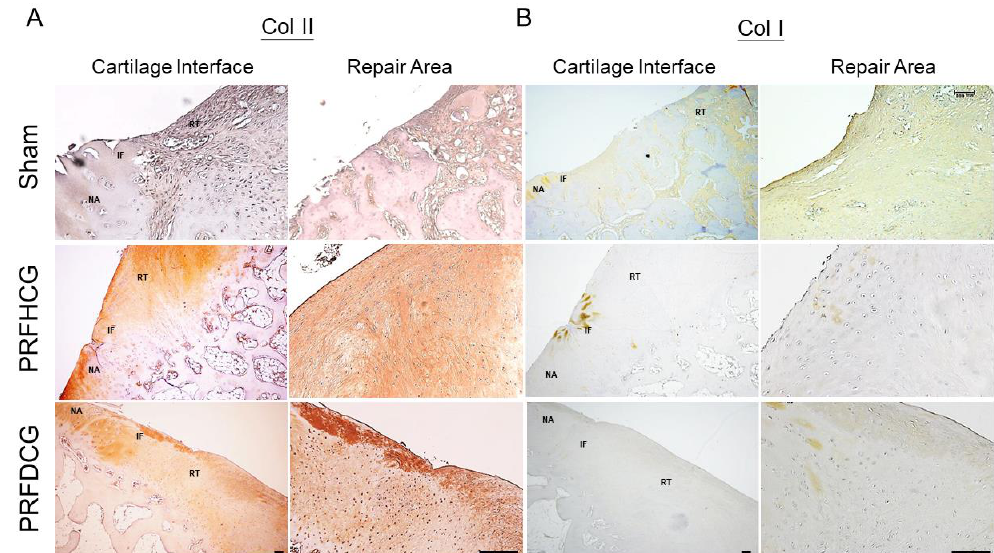
Figure 6. Immunostaining of the repair tissue by antibodies to collagen type II (Col II) and collagen type I (Col I). ( A ) In PRFHCG and PRFDCG groups, the repair areas were stained positively for Col II (brown stained region) but negatively for Col I. ( B ) In control group, the repair area was mainly composed of fibrous tissues that were positively stained for Col I (light brown stained region). Scale bar: 100 μm.